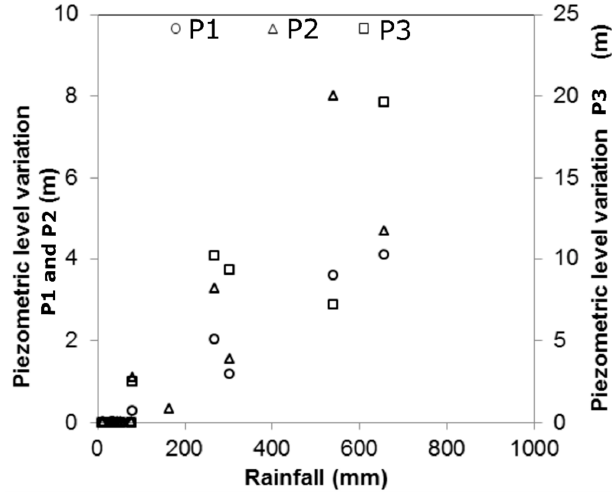
Figure 9. Relationship between the piezometric variations in observation wells P1, P2 and P3